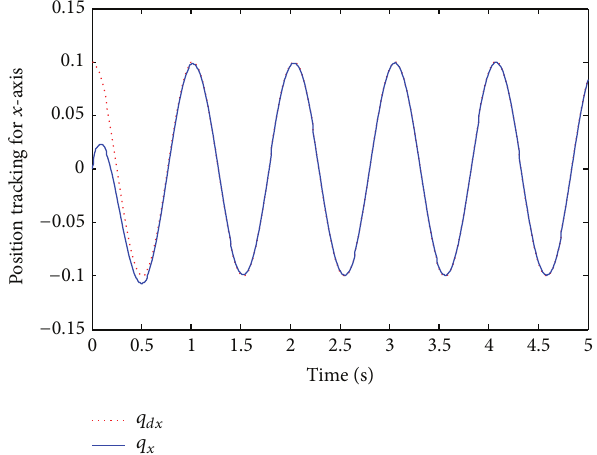
Figure 4: Position tracking of 𝑥 -axis with adaptive neural sliding compensator.